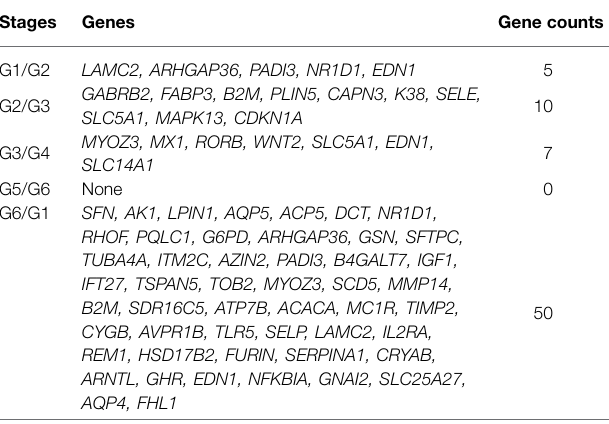
TABLE 2 | Genes obtained from unite analysis of methylated DNA immunoprecipitation sequencing (MeDIP-Seq) and